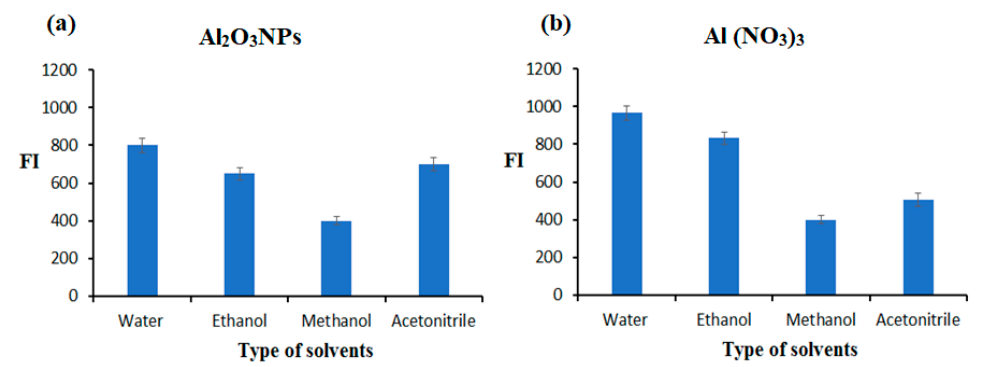
Figure 6. Effect of solvents on the FI of 1.0 µ g mL − 1 AMH soluble in various solvents in the absence of ( a ) metal oxide nanoparticles (Al 2 O 3 NPs) and ( b ) metal-chelating agent (Al(NO 3 ) 3 ).